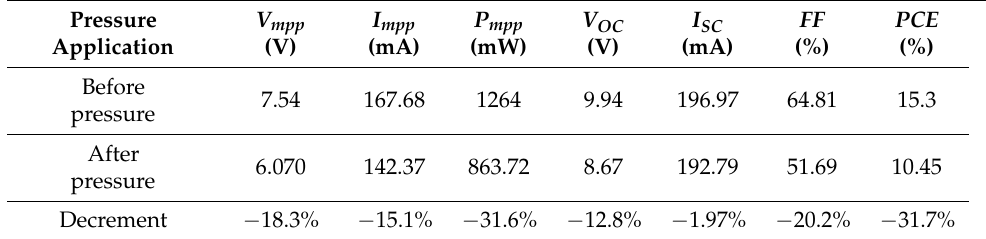
Table 2 . Electrical parameters for module produced by using a non-optimized P3 process, extracted by I-V curves acquired (reported in Figure 8a) before and after the application of the lamination pressure, and their relative variations in percentage.